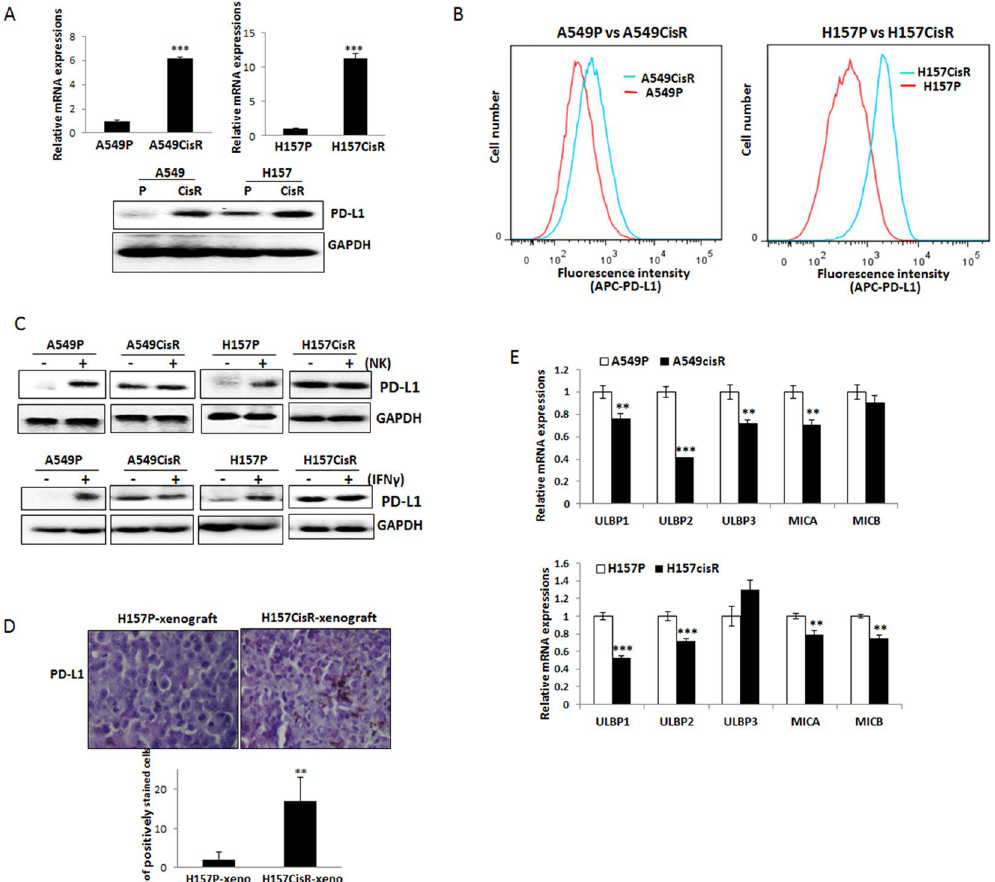
Figure 2. PD-L1/NKG2D ligand expressions in cisplatin-resistant cells vs. parental cells. ( A ) qPCR (upper panel) and Western blot (lower panel) analyses detecting expressions of PD-L1 in A549P/A549CisR and H157P/H157CisR cells. ( B ) Flow cytometric analyses of PD-L1 in A549P/A549CisR and H157P/H157CisR cells. Relative fluorescence stained with APC-conjugated anti-PD-L1 Ab was shown. ( C ) Western blot analysis of PD-L1 in A549P/A549CisR and H157P/H157CisR cells after co-culture with NK cells. Upper panel shows the PD-L1 levels in A549P/A549CisR and H157P/H157CisR cells after co-culture with NK cells for 4 hours. Lower panel shows the PD-L1 levels in A549P/A549CisR and H157P/H157CisR cells after incubation (4 hours) with recombinant human IFN γ (rhIFN γ ). ( D ) IHC staining of PD-L1 in tumor tissues of H157P and H157CisR- derived xenografts. PD-L1 levels in tumor tissues, derived from H157P cell and H157CisR cell-derived xenografts were examined. Error bars and significance values were obtained by counting positively stained cells in one randomly chosen phase of slides of 3 different stains. Magnification, 20X. ( E ) qPCR analyses of NKG2D ligands in A549P/A549CisR and H157P/H157CisR cells. ** p < 0.01, *** p <